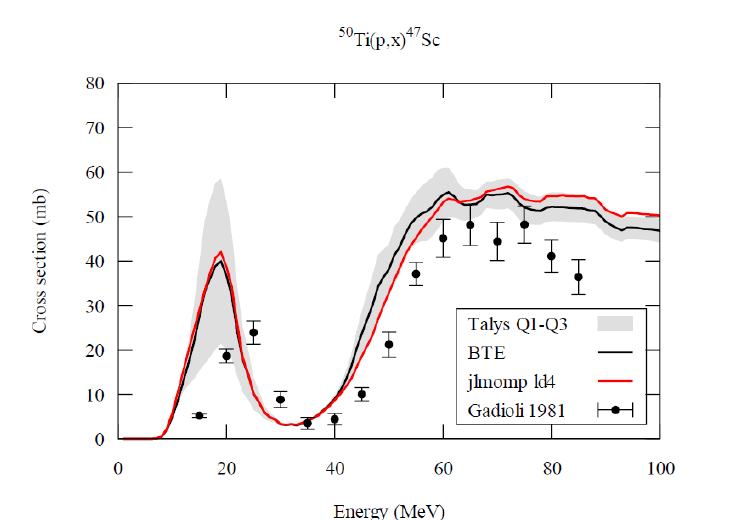
Fig. 4. Experimental and theoretical cross sections for the reaction 50 Ti(p,x) 47 Sc. Notations and legend same as Fig